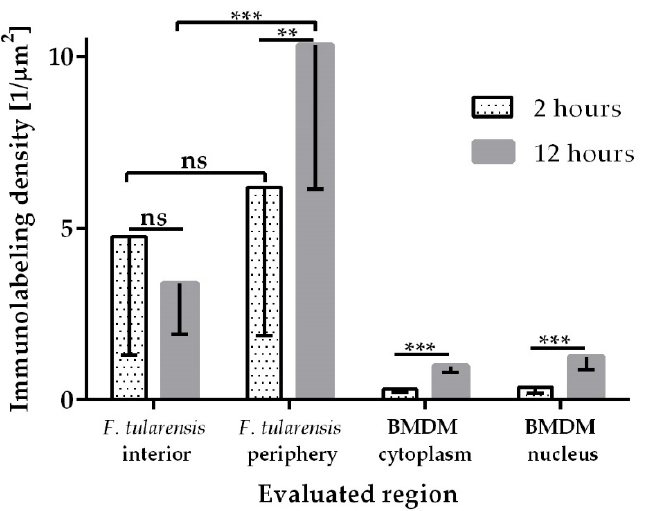
Figure 3. Comparison of immunogold-labeling density in specified compartments of bacterial cells and host cells. The density was calculated as a ratio between the number of gold nanoparticles in a specified region and its area in µ m 2 . Statistical significance was determined by t -test and ANOVA (** p < 0.01; *** p < 0.001, ns = not significant p > 0.05). Error bars indicate the SD of values obtained from four evaluated regions of 18 randomly selected host cells per each variant.